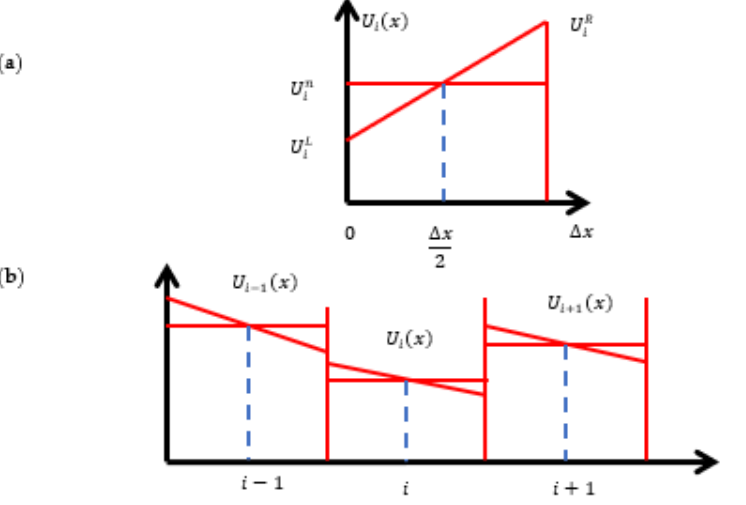
Figure 12. ( a ) Linear MUSCL reconstruction of data in single computing cell; ( b ) linear MUSCL reconstruction for three successive computing cells.